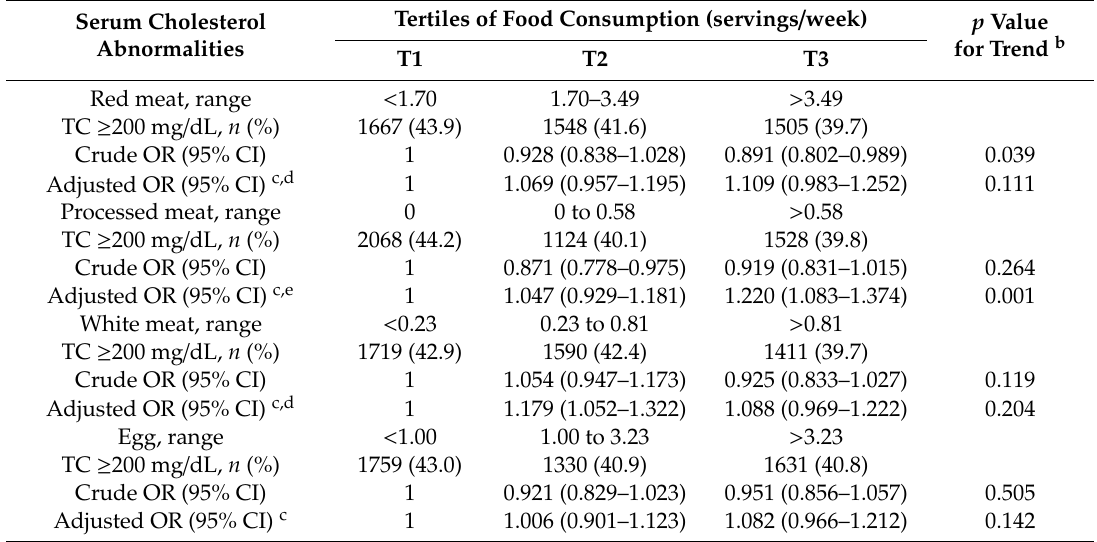
Table 3. Associations between consumption of food sources of dietary cholesterol and the risk for abnormalities in total cholesterol level a .